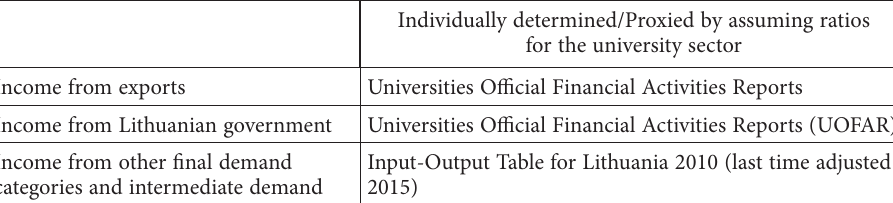
Table 5. Summary of HEI rows (source: compiled by authors) Individually determined/Proxied by assuming ratios for the university sector Income from exports Universities Official Financial Activities Reports Income from Lithuanian government Universities Official Financial Activities Reports